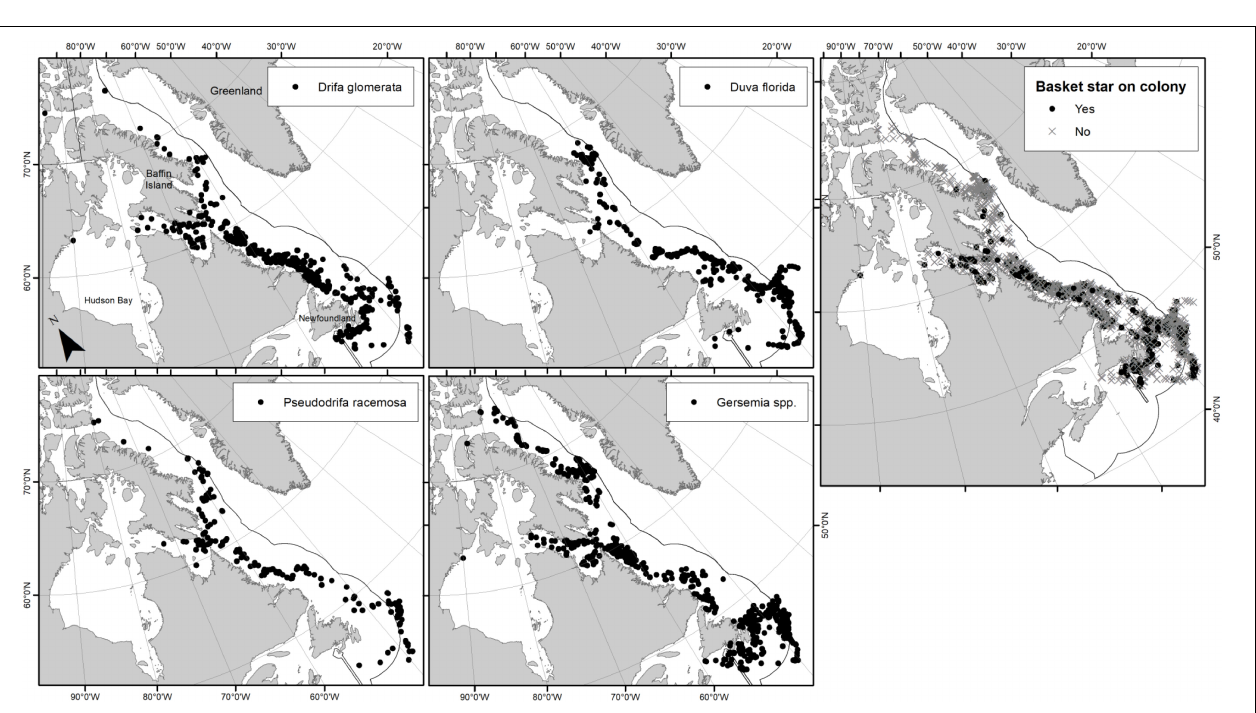
FIGURE 3 | Distribution of examined soft coral samples per taxa, and overall presence-absence of juvenile basket stars on examined soft coral colonies (right panel). Dots on panels per taxa only indicate soft coral presence, not associated basket stars.